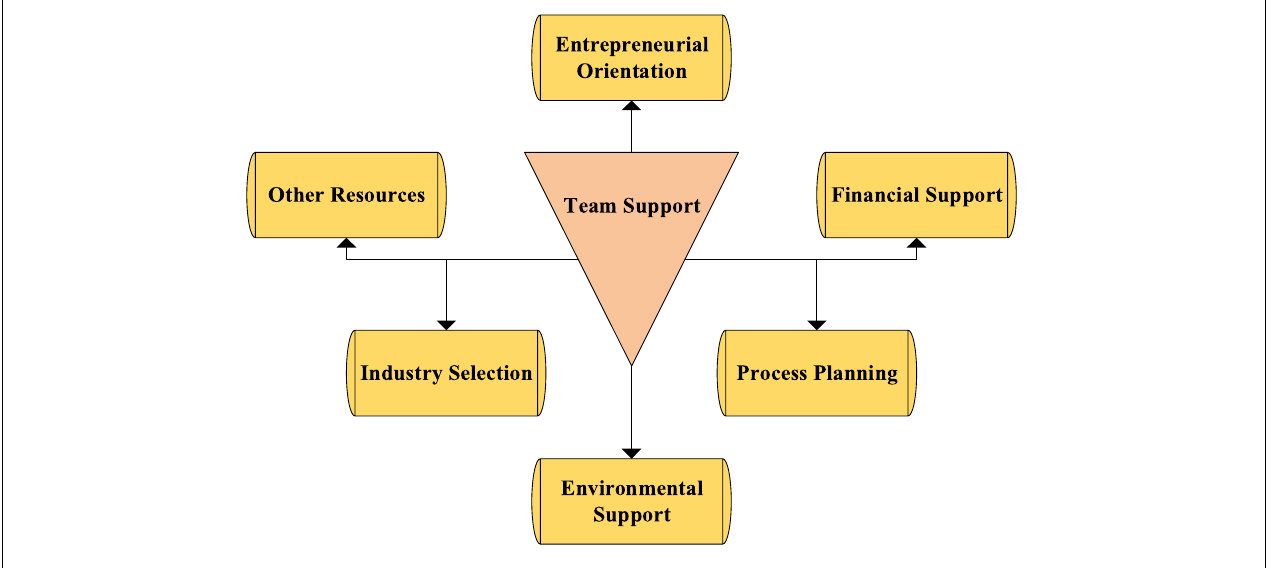
FIGURE 5 | Structure diagram of entrepreneurial propensity.